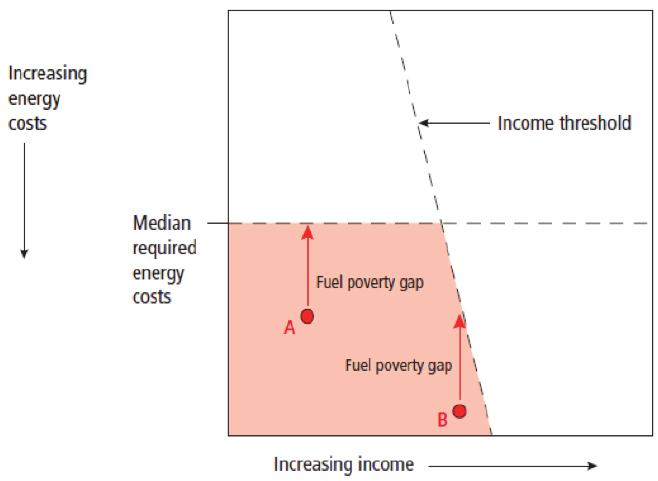
Figure 1: Representation of the Low Income High Costs indicator and fuel poverty gap